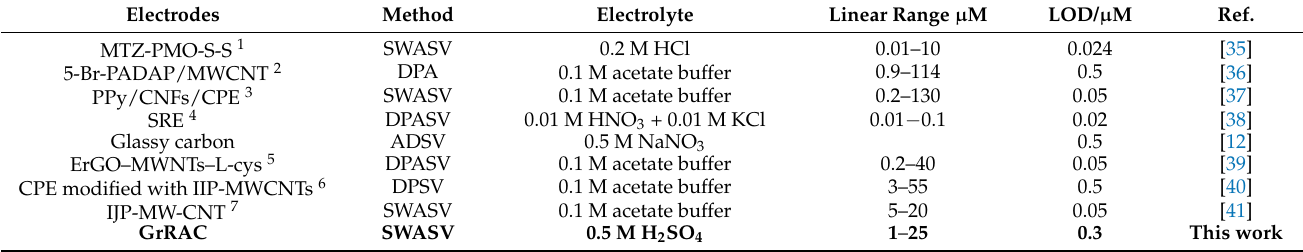
Table 1. Comparison of the analytical parameters of the sensors reported in the literature for the determination of Pb(II). Electrodes